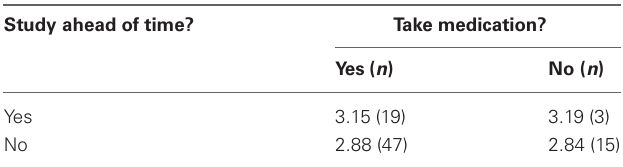
Table 2 | GPA of ADHD students: relationship between study habits and